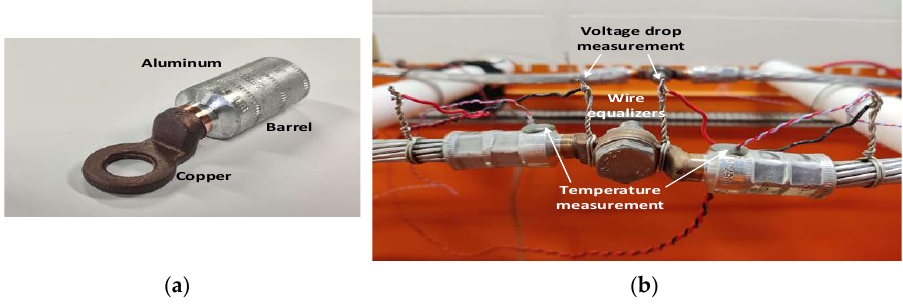
Figure 4. ( a ) Bimetallic aluminum – copper connector before compression. ( b ) Connectors placed in the loop to run the heat cycles illustrating the voltage drop and temperature measurements to obtain the electrical resistance. Wire equalizers allow generating an equipotential measuring point to improve the accuracy of the voltage drop measurement.